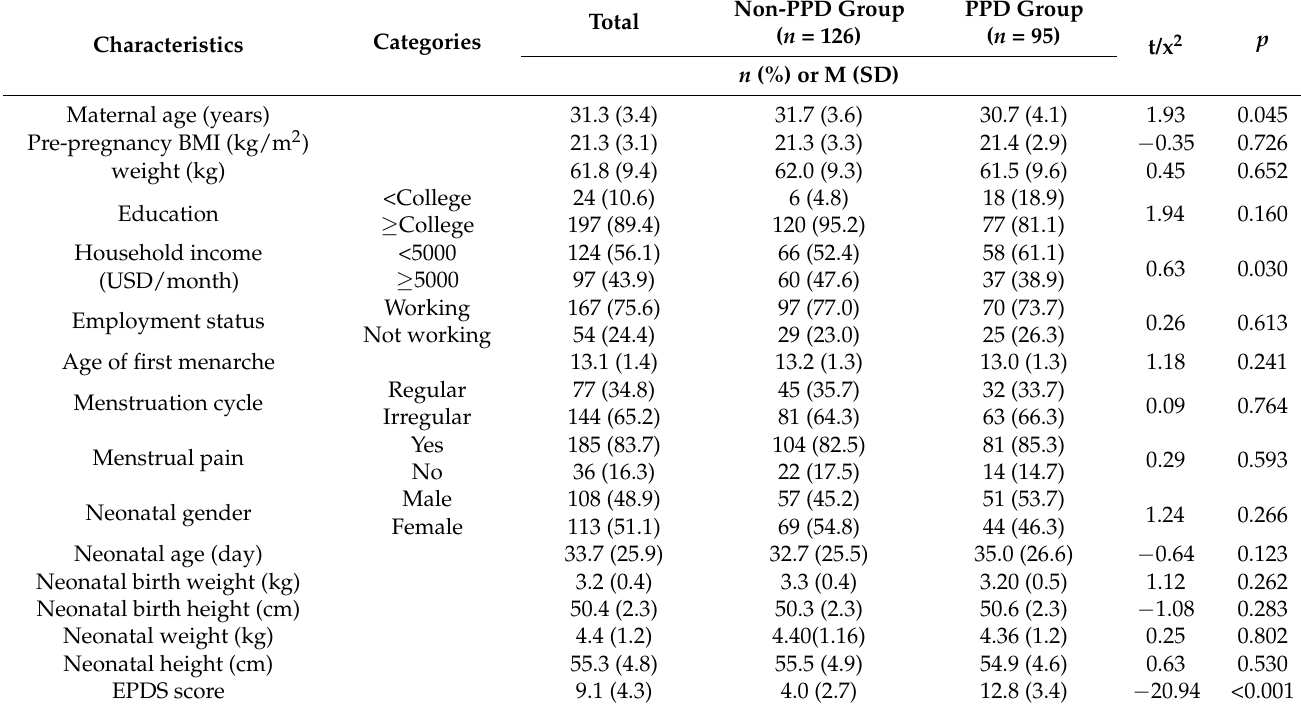
Table 1. Socioeconomic and perinatal characteristics of